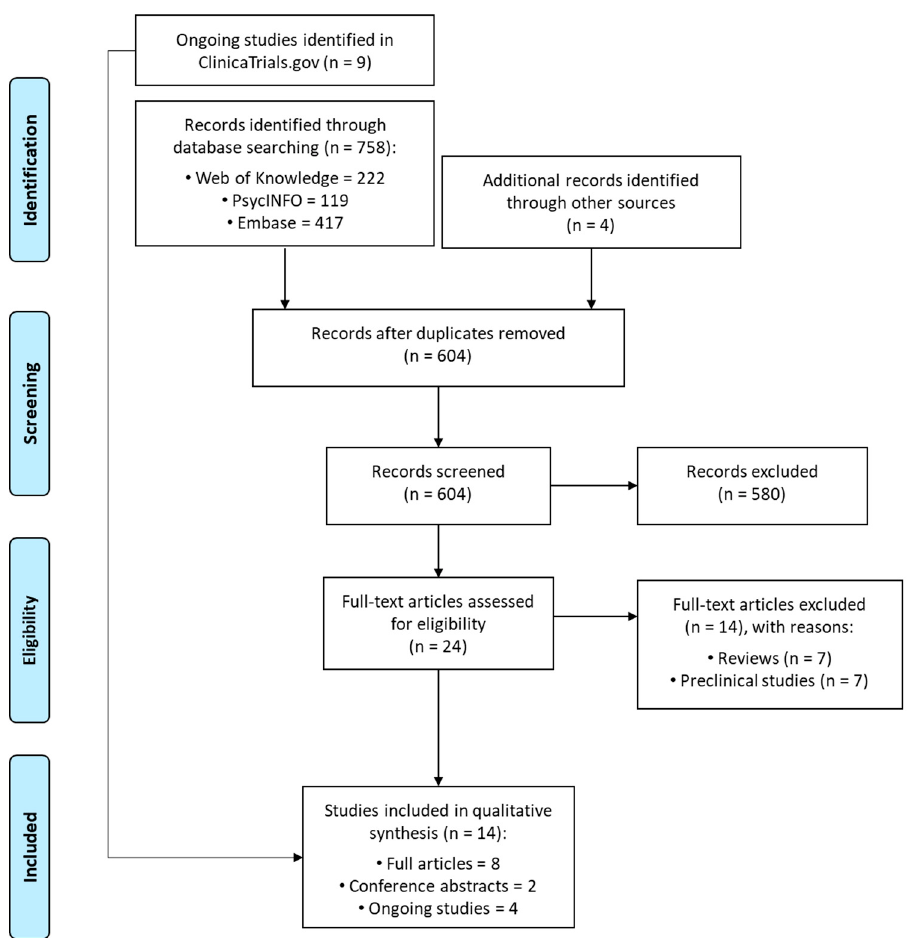
Figure 1. PRISMA flow chart of the study selection process.